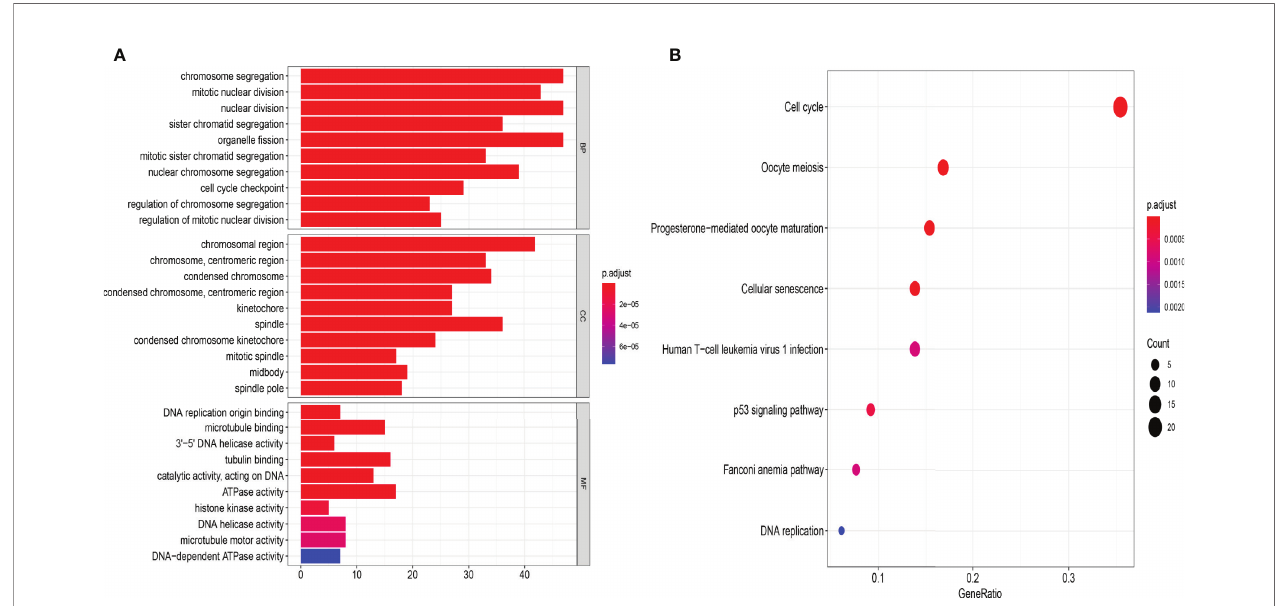
FIGURE 8 | The mechanism of the fi ve-lncRNA model. (A) GO enrichment analysis. MF, CC and BP words represented the GO terms for molecular functions, cellular components and biological processes, respectively. The y-axis represented the obvious enrichment path of model. The x-axis represented the gene numbers of model, and the color represented different p values. (B) The fi rst 8 functional pathways related to these genes were revealed by KEGG analysis. The y-axis represented the obvious enrichment path of model. The enrichment factor on the x-axis indicated the degree of enrichment. The higher the value of the enrichment factor, the higher the degree of richness. The color of the dot represented different p values, and the size of the dot re fl ected the number of target genes enriched in the corresponding